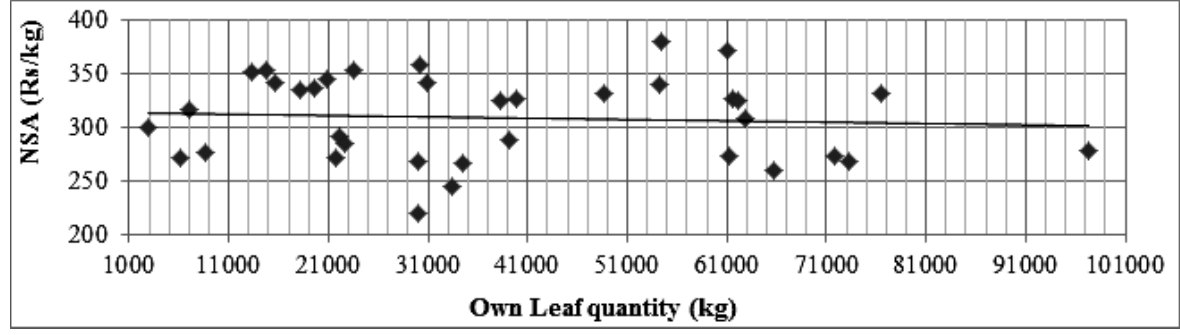
Fig 15: Relationship of Main Grade Percentage with NSA in Udu Pussellawa The source of raw material (own leaf) and the quality of raw material (leaf standard) with NSA is given opposite results in UduPussellawa (see fig 16 and 17).